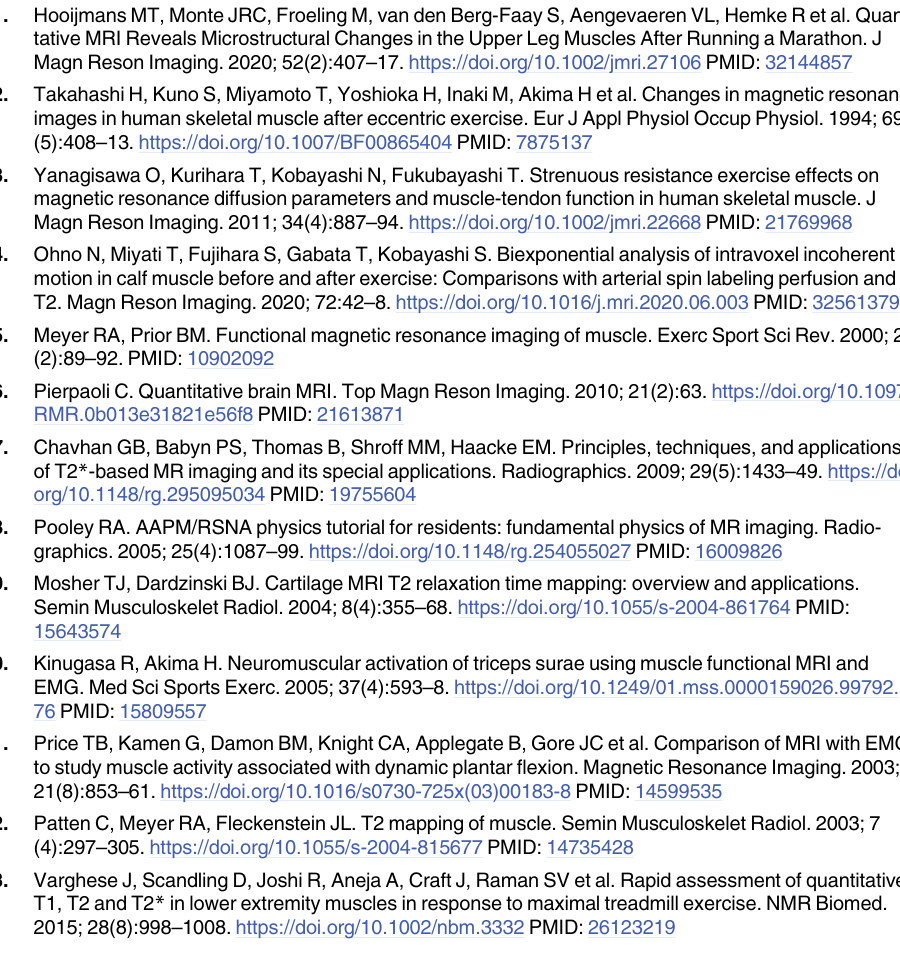
S1 Fig. Example of muscle segmentation. The borders of the segmented muscles are shown as a green line. The segmentation has been performed in the first echo of the T2-sequence (a), as it provided the best contrast for the anatomical structures, and then copied to the T2 map (b) and the T2 � map